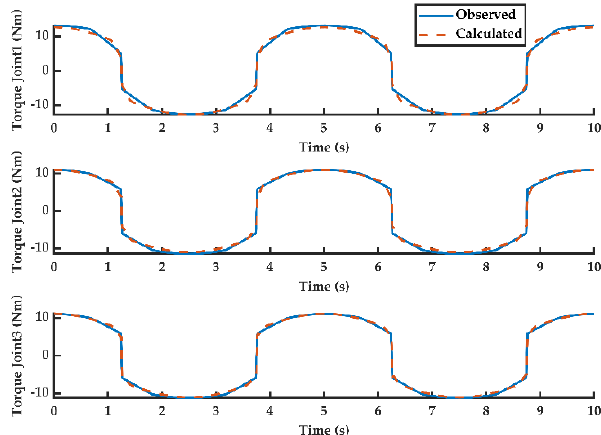
Figure 2. Calculated friction joint torque and observed disturbance.